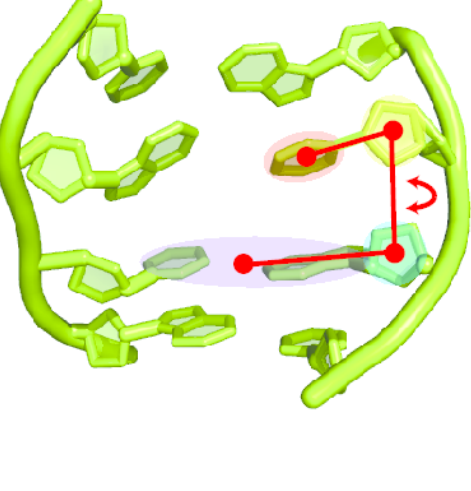
Figure 8. Definition of the reaction coordinate for the base flip simulations: the flip angle is a pseudo-dihedral between the centers of mass of the flipping base (red shade), the sugar moiety of the same nucleotide (yellow shade), the sugar moiety of the next nucleotide (green shade) and the base of the next nucleotide, plus the complementary base in the other DNA strand (blue